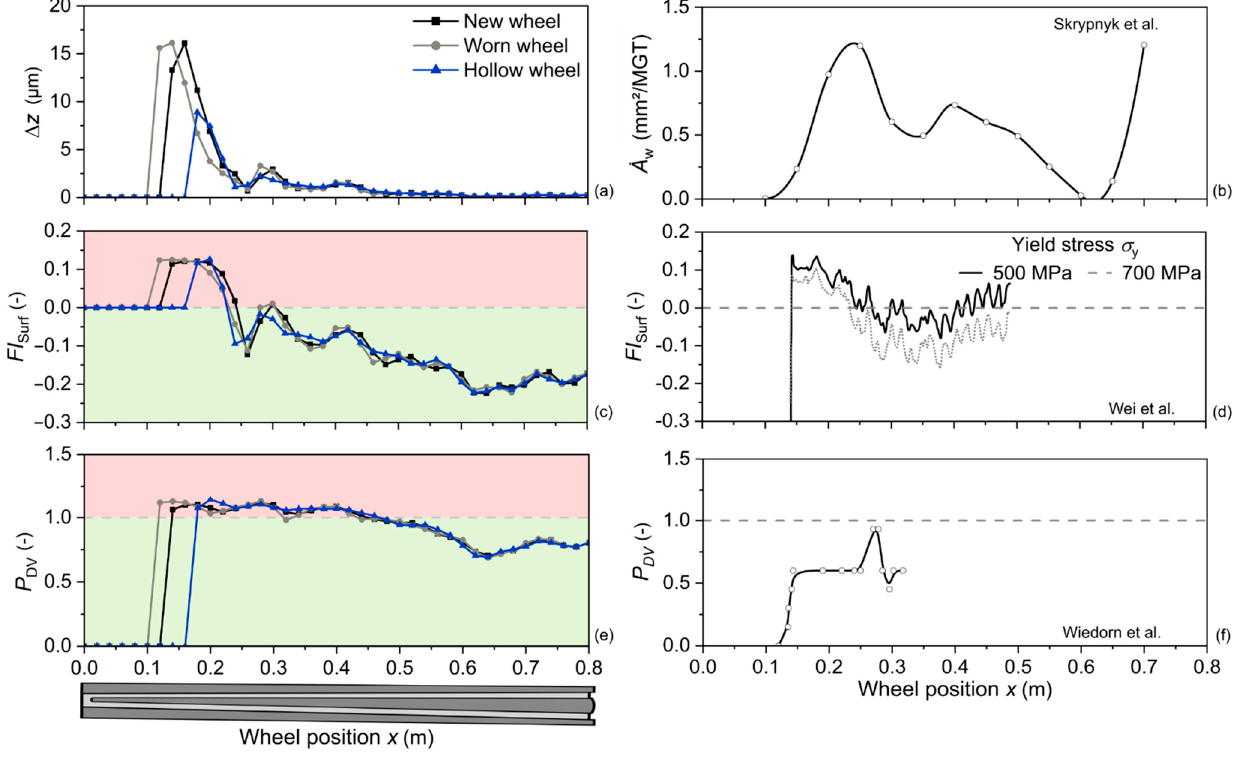
Figure 15. Local evolution of damage indices along the EDH Mn13 run-in crossing nose with measured rail profile after 11.9 MGT traffic: ( a ) wear depth per wheel pass ( Δ z ), ( c ) surface fatigue index ( FI surf ) and ( e ) Dang Van index ( P DV ). Results from comparable model evaluations in the literature: ( b ) wear area rate ( A w ) for a manganese crossing nose considering mixed traffic conditions [13], ( d ) FI surf reported in [18] for different material yield stresses and ( f ) P DV published in [11] for a manganese crossing nose. In ( d , f ), the wheel positions were adapted to coincide with present investigations, as no details were available in the publications.